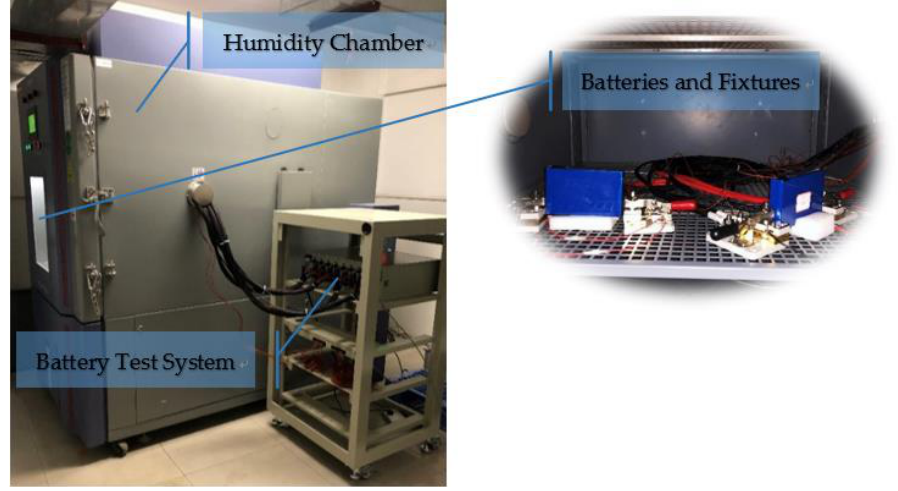
Figure 3. Experiment platform.